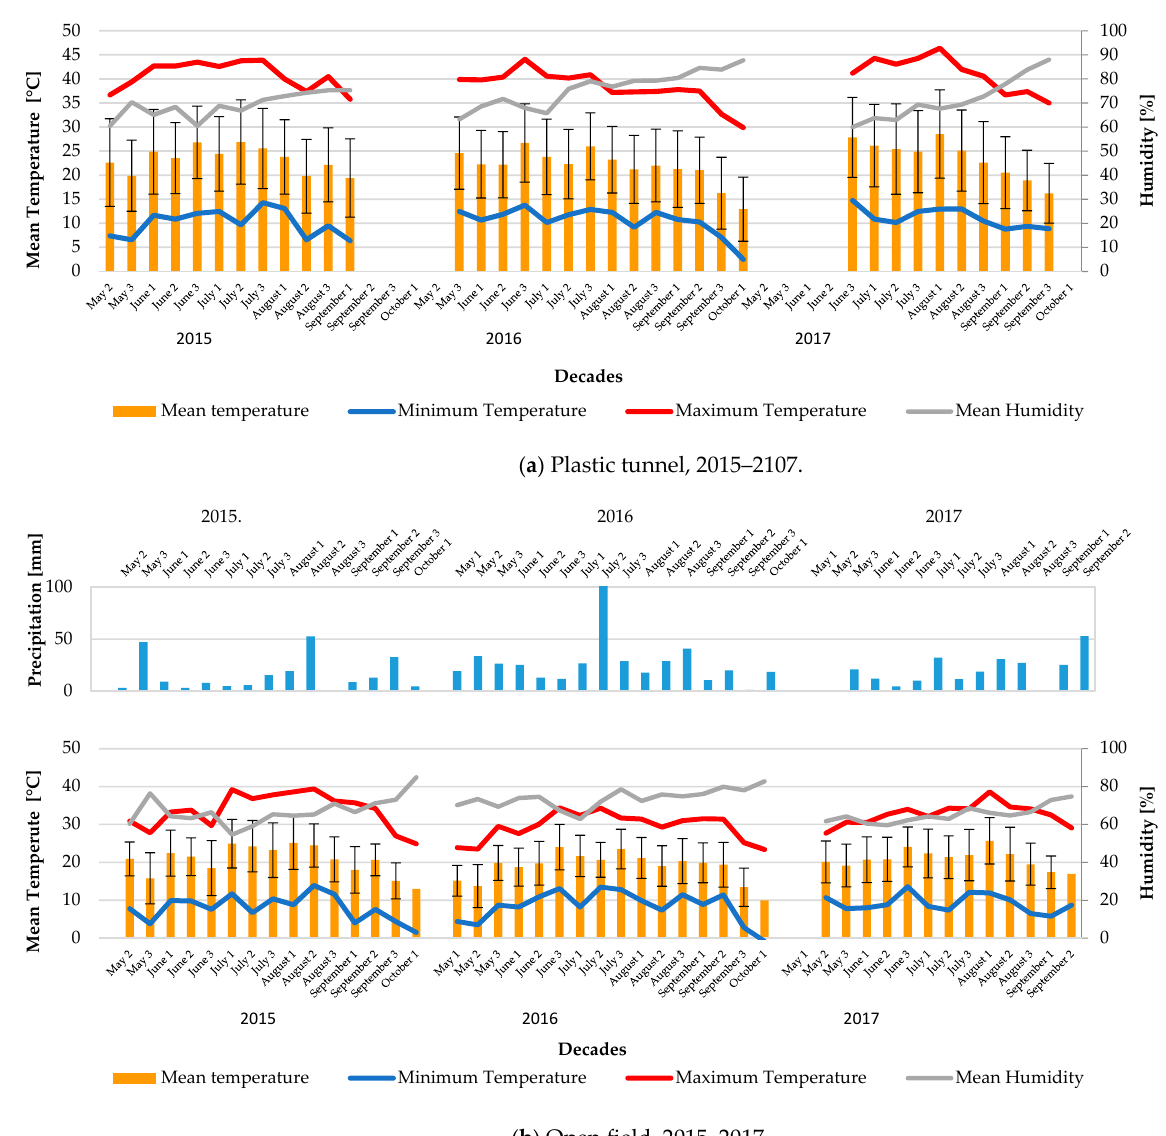
( a ) Plastic tunnel, 2015–2107.